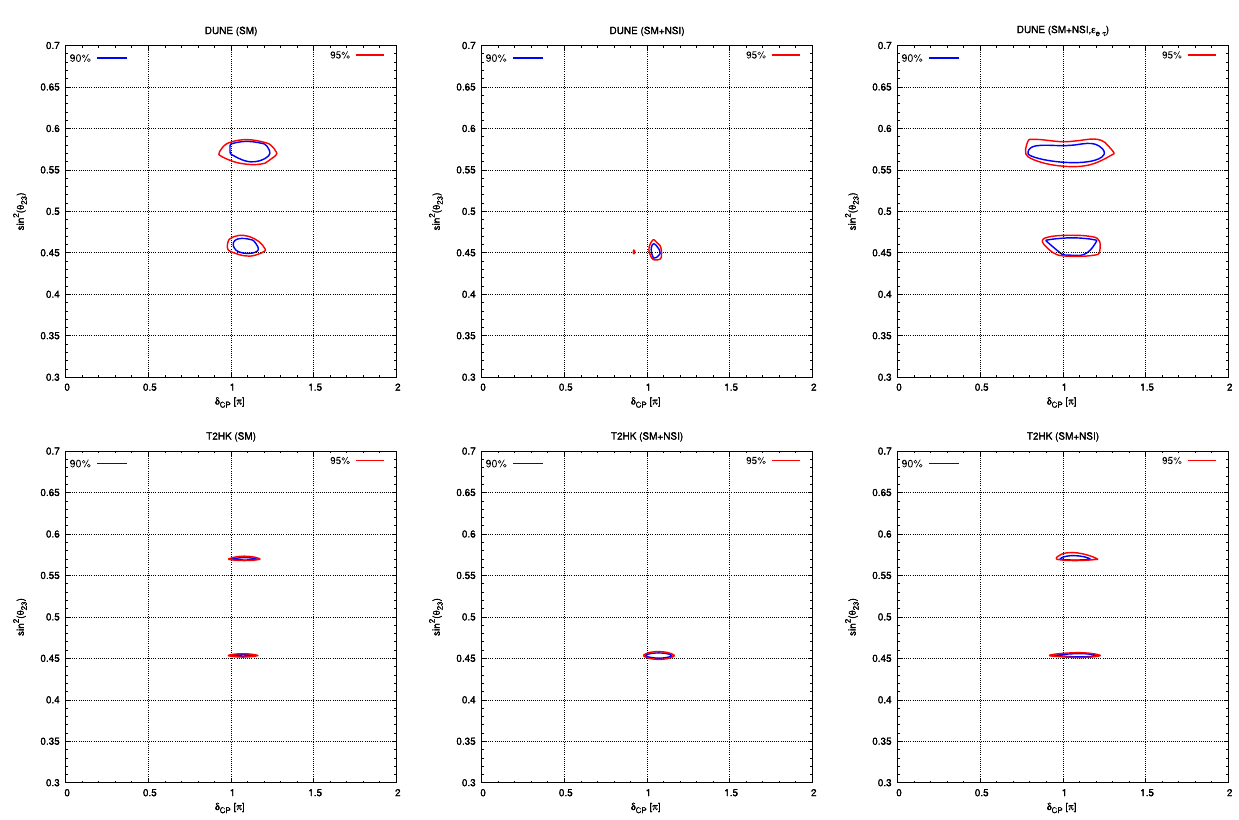
Fig. 3 Allowed regions determined separately by DUNE and T2HK for NO in the SM case (left panel) and with NSI in the e − μ sector (middle panel) and in the e − τ sector (right panel). In the middle panel we have taken the NSI parameters at their best fit values of NO ν A+T2K